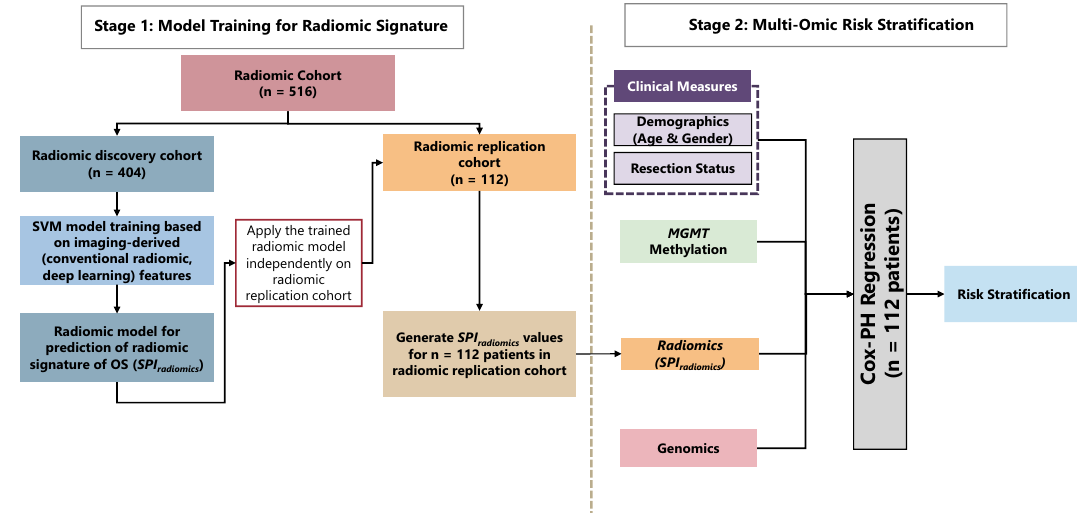
Figure 1. Multi-omic analysis method for risk stratification of patients with IDH -wildtype GBM tumors based on their radiomic signature (SPI radiomics ), clinical measures [age, gender, and extent of resection (EOR)], and molecular information ( MGMT methylation and genomics, obtained by next-generation sequencing (NGS) of the tumor